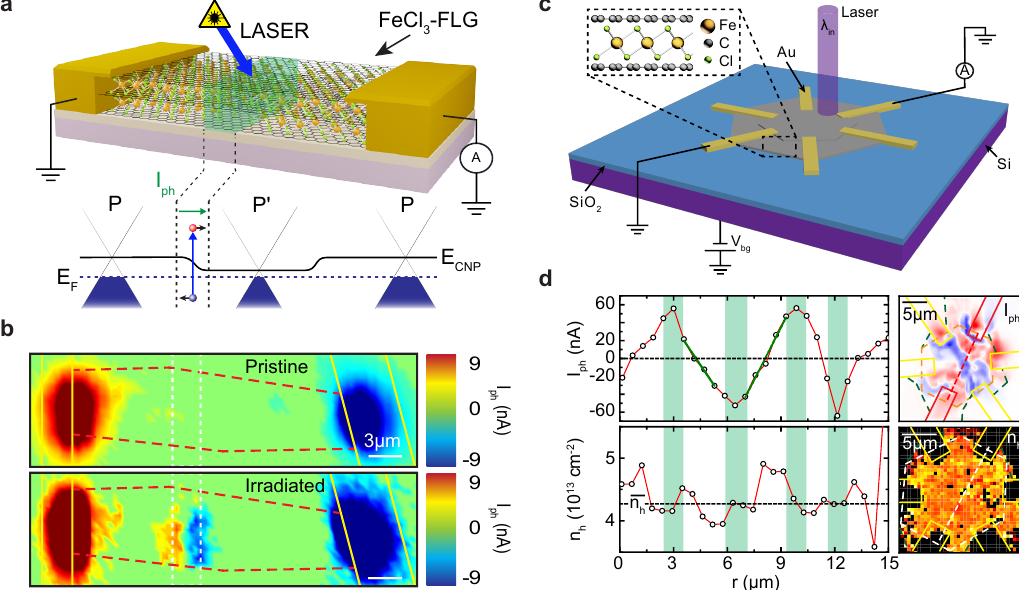
Figure 3. FeCl 3 -FLG Photodetectors. ( a ) laser-defined p-p’ junction in FeCl 3 -FLG device, E CNP is the charge neutrality point and E F is the Fermi level; ( b ) scanning photocurrent ( I ph ) maps before (top) and after (bottom) laser-irradiation along the white dashed lines. Red dashed lines delimit the FeCl 3 -FLG flake, laser wavelength was 375nm. Adapted and reprinted with permission from De Sanctis et al. [14], under CC-BY license from AAAS, 2017; ( c ) schematic of a multi-terminal hexagonal-domain FeCl 3 -FLG photodetector and measurement circuit; ( d ) photocurrent ( I ph , top) and charge density ( n h , bottom) extrapolated from the corresponding maps (right panels); green shaded areas represent maxima and minima of the photocurrent which correspond to a change in charge density. Reproduced with permission from De Sanctis et al. [70], under CC-BY license from IOP Publishing Ltd. (Bristol, UK),